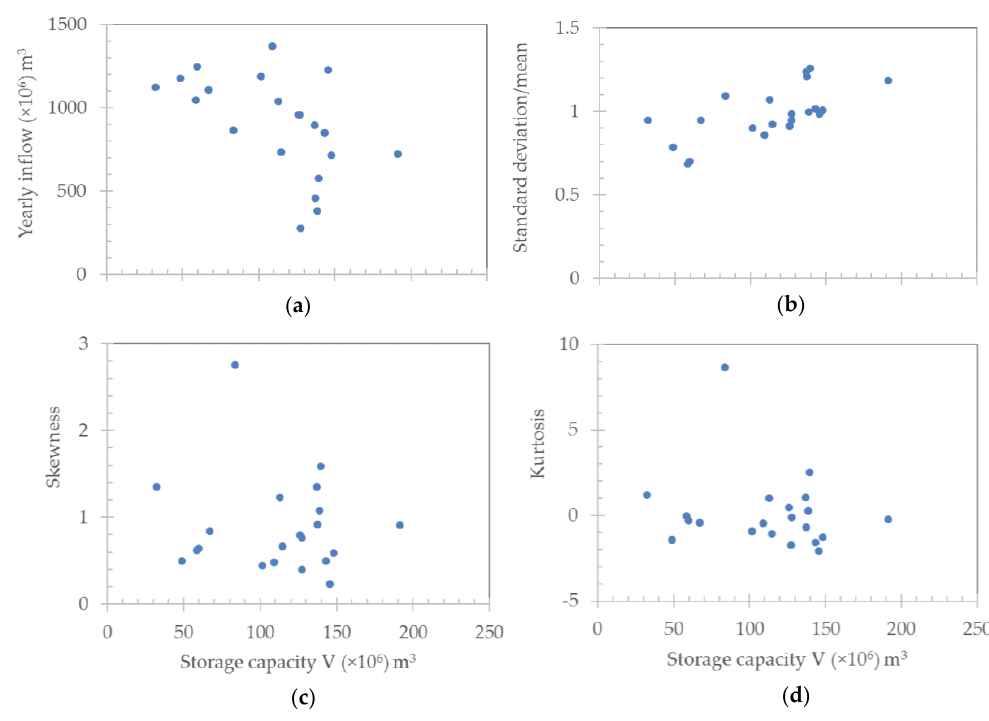
Figure 2. Correlations of reservoir capacity V to: ( a ) yearly inflow; ( b ) standard deviation of monthly mean inflows/monthly mean; ( c ) skewness of monthly mean inflows; ( d ) kurtosis of monthly mean inflows.